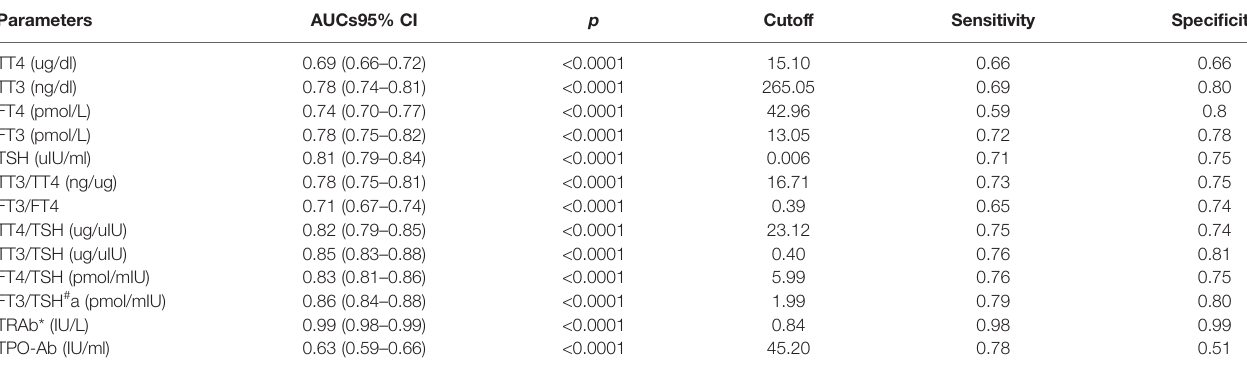
TABLE 3 | Receiver operating characteristic curve analysis of thyroid-related parameters for distinguishing Graves ’ disease from autoimmune thyroiditis. Parameters